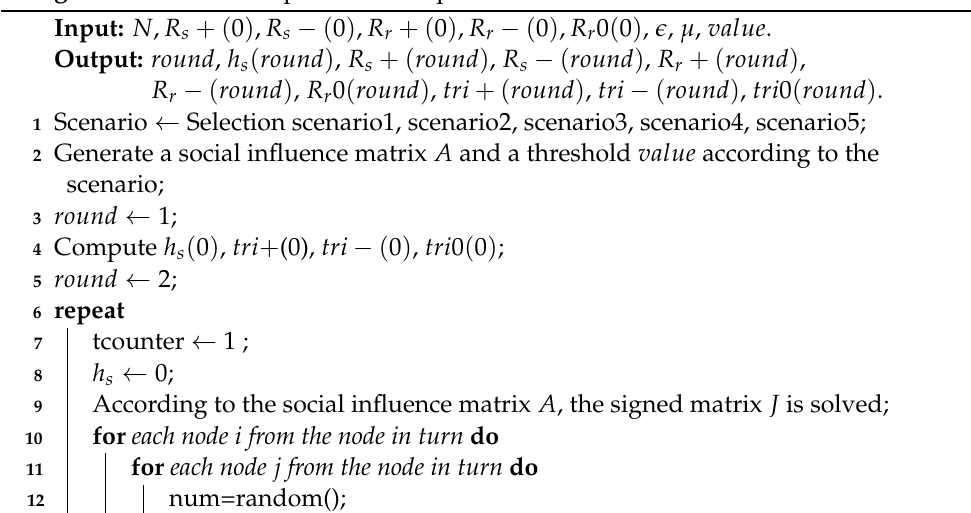
Algorithm 1: Model implementation process